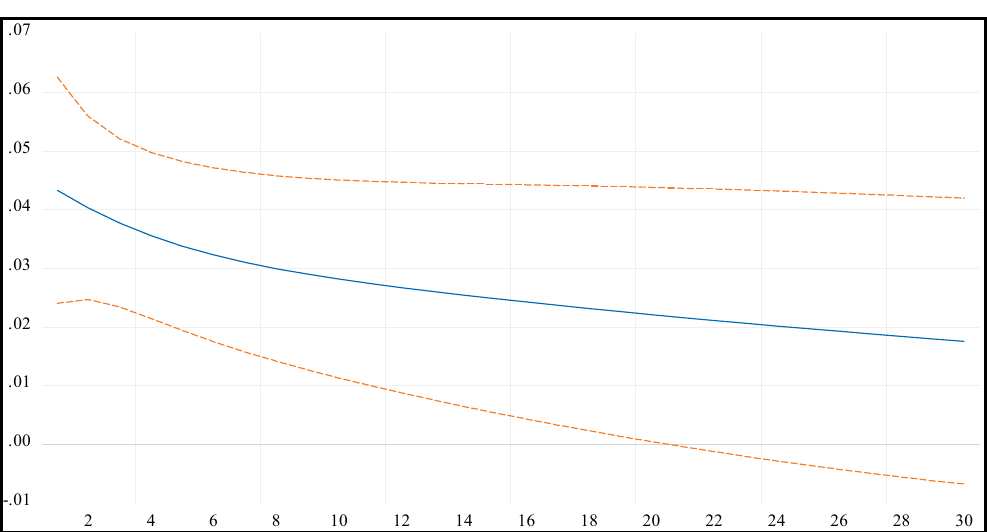
Figure 3. Stability of Vector Autoregressive Model.